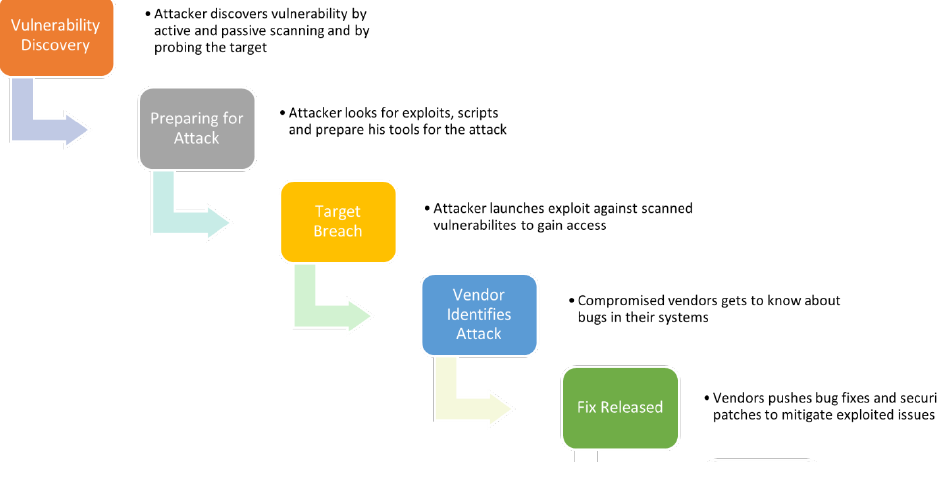
Figure 2. Zero-day attack detection